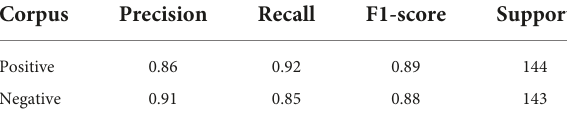
TABLE 4 Model experiment results.